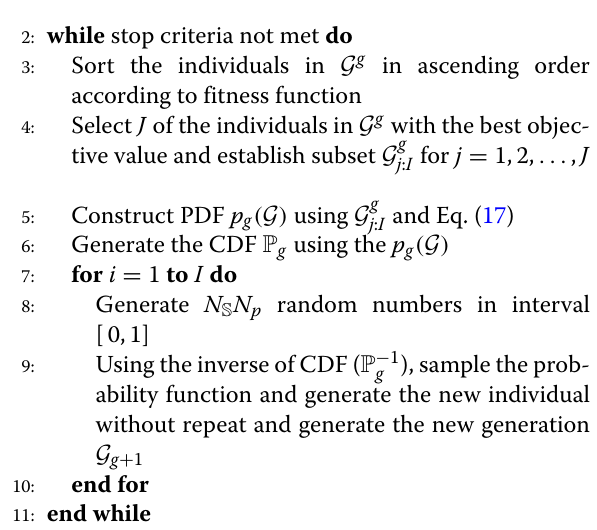
Algorithm 3 Extended EDA-based pilot